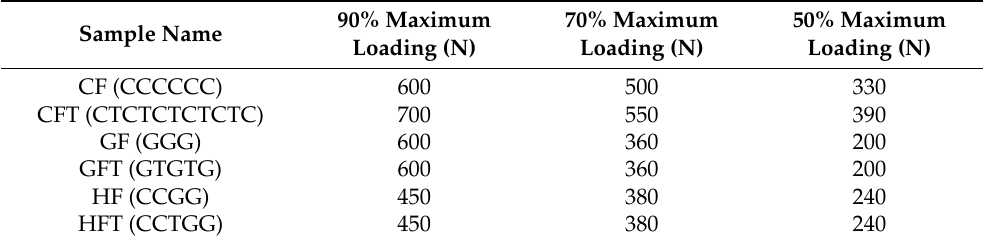
Table 3. Flexural loading for cyclic testing in N. With carbon fibre ply’s labelled with C and glass fibre ply’s labelled G the inclusion of veil toughening is labelled with a T.